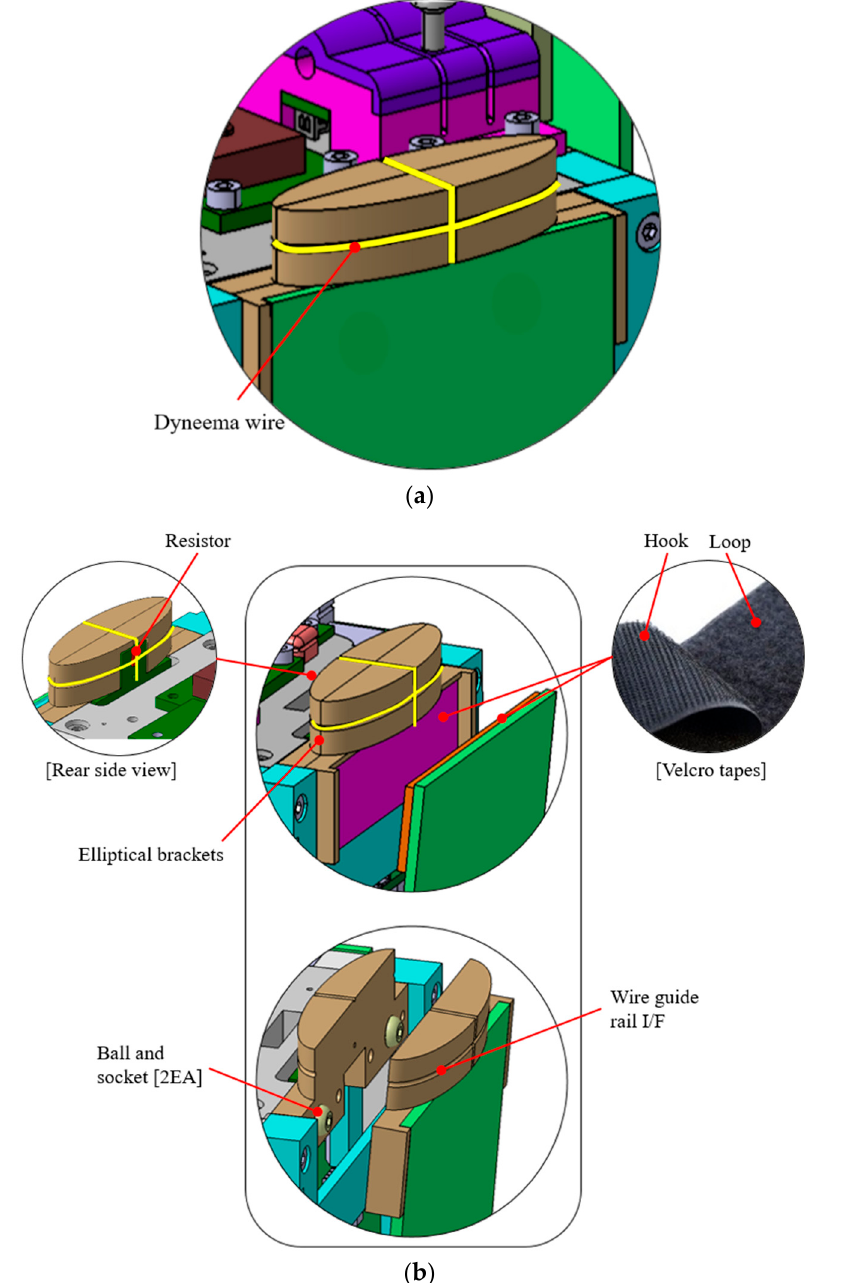
Figure 6. Close-up views of the Velcro tape-type HRM showing the ( a ) fully stowed and ( b ) partially deployed solar panels. Table 3. Specifications of the double-sided adhesive tape.